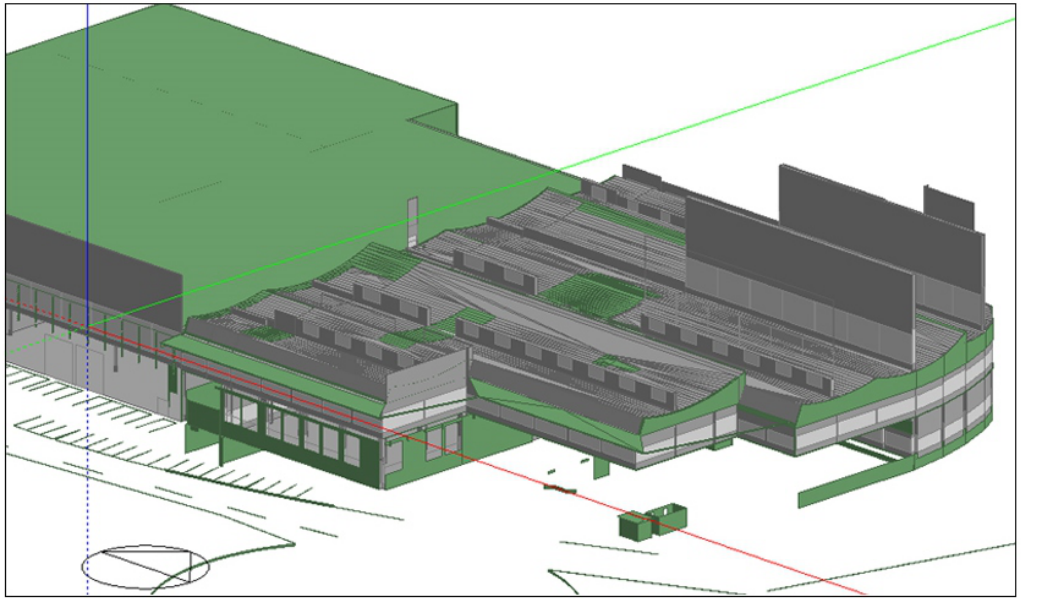
Figure 6. Warehouse gbXML file imported in Design